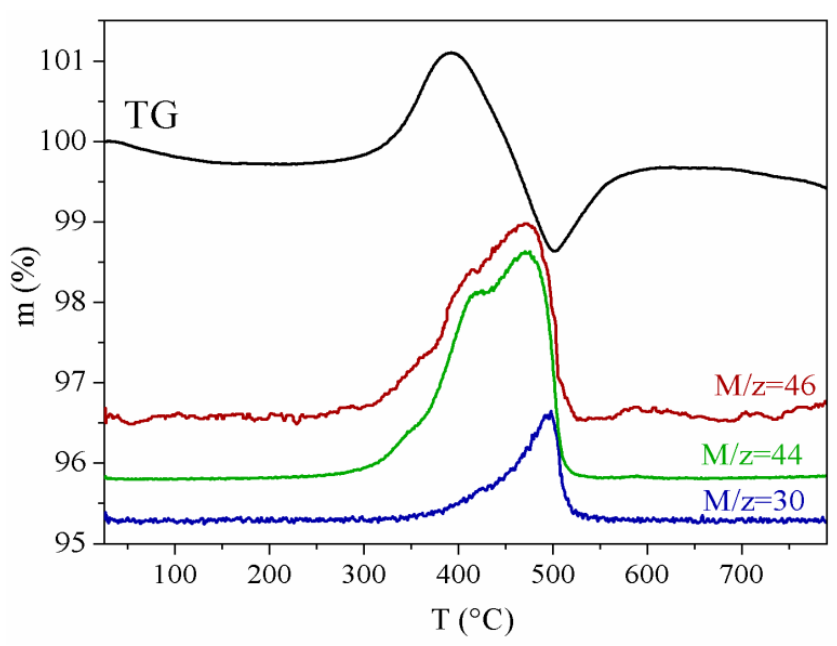
Figure 4. Thermogravimetric curve (TG) and ion currents with numbers (M/z) 46, 44, and 30 vs. the temperature for LFP/C PANI -II.